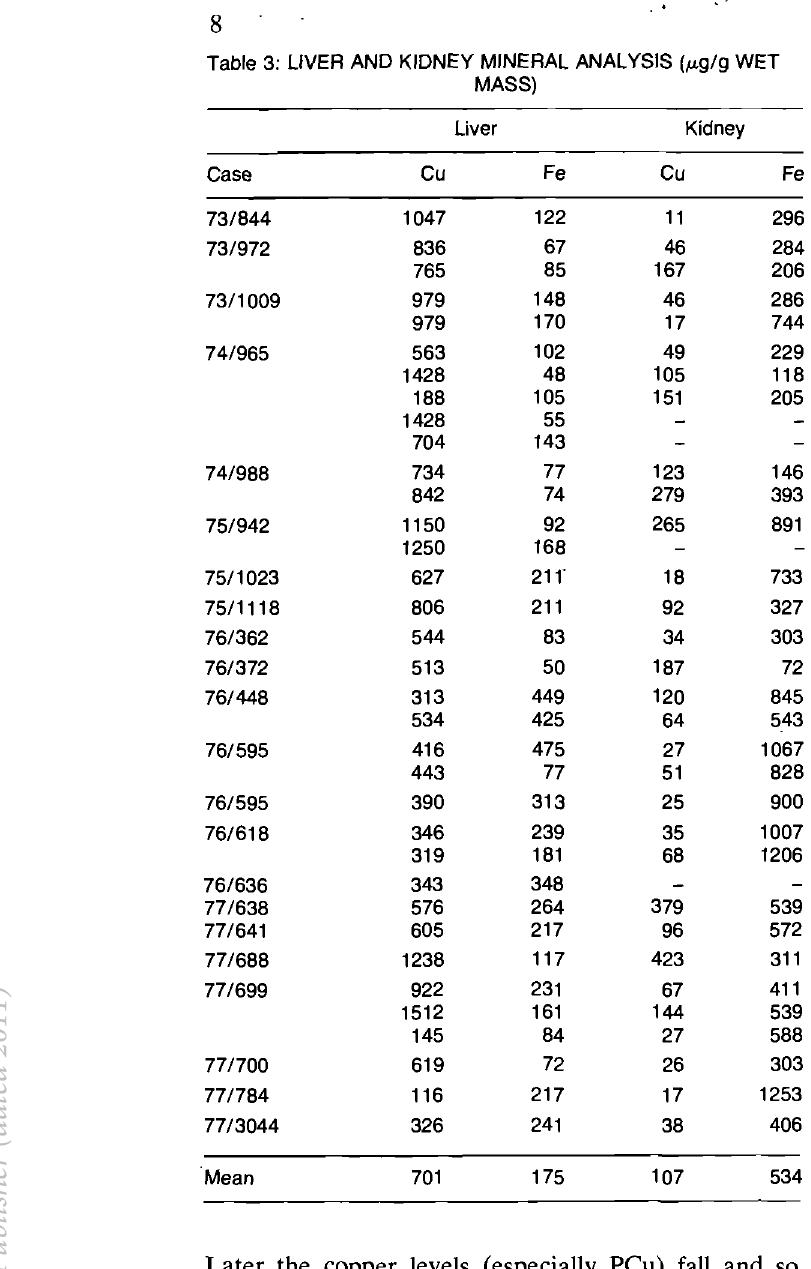
Table 3: LIVER AND KIDNEY MINERAL ANALYSIS (J.Lg/g WET MASS)